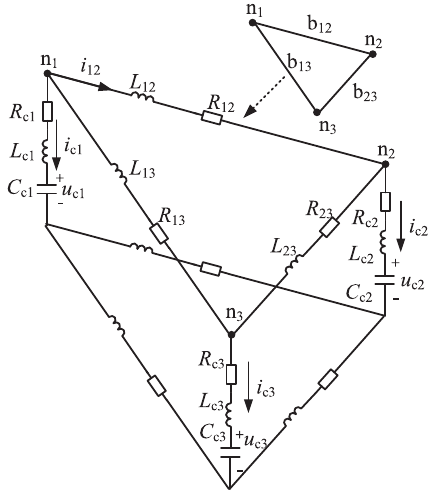
Fig. 3. An arbitrary dc grid structure.